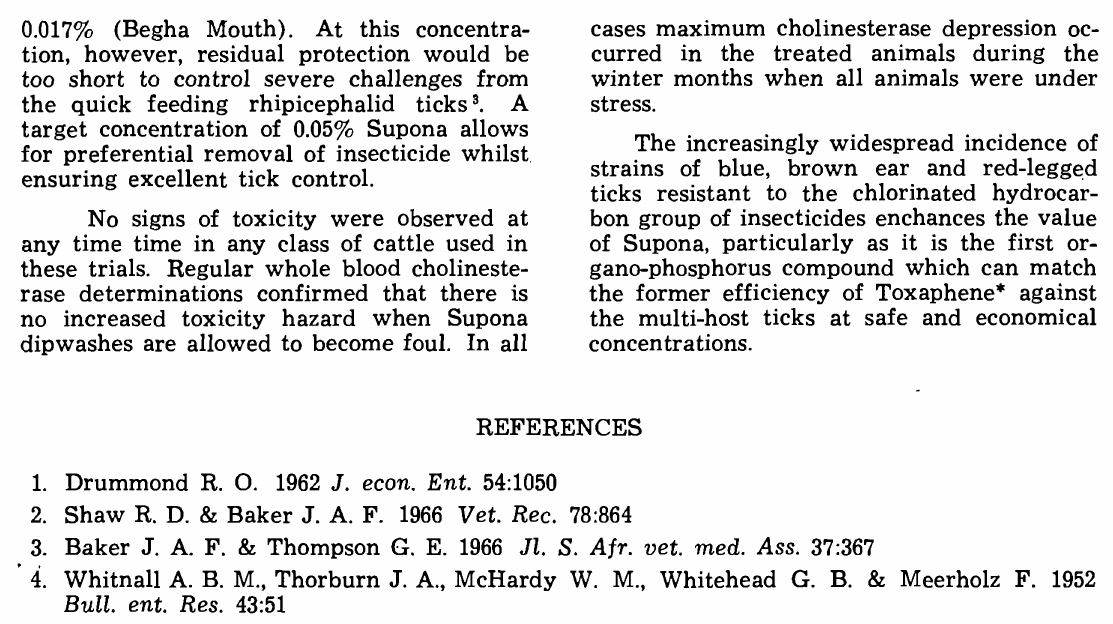
TABLE: CHECK ON CONTINUED BIOLOGICAL EFFICIENCY OF SUPONA DIPWASH: WILTONSIDE; 57th DIPPING; MULTIHOST TICK COUNTS AVE. OF 3